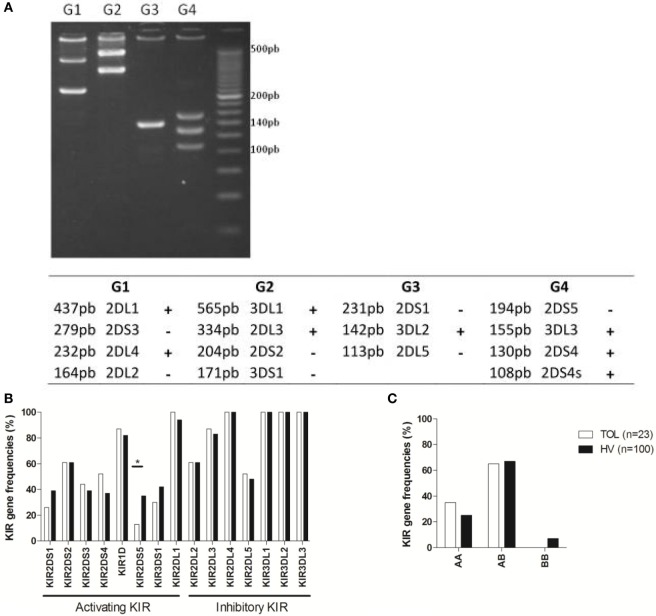
Representative 3% agarose gel electrophoresis of KIR multiplex polymerase chain reaction-SSP products and corresponding KIR amplification patterns and KIR profile in kidney transplanted patients. (A) The figure represents the presence (+) or absence (−) of each KIR gene in one representative tolerant patient (TOL) with the four groups of primers (G1, G2, G3, and G4) allowing the detection of all functional KIR genes. KIR primer-pair groups provide short amplicons from 108 to 565 bp. (B) Representation of the KIR genotype frequencies TOL (n = 23) and healthy volunteer (HV) (n = 100). (C) KIR genotype AA, AB, and BB frequencies in TOL (n = 23) and HV (n = 100). Significance was defined as *p < 0.05, **p < 0.01, ***p < 0.001, and ****p < 0.0001.